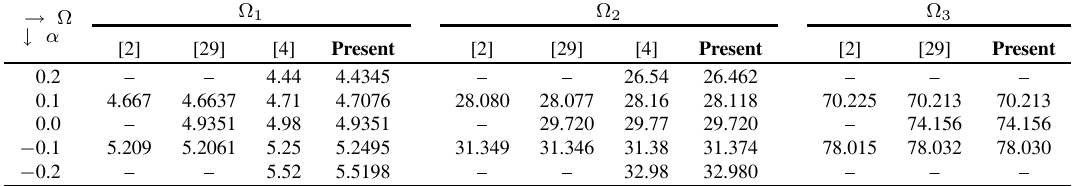
Table 4 Comparison of Ω for isotropic circular plates of linearly varying thickness with simply supported